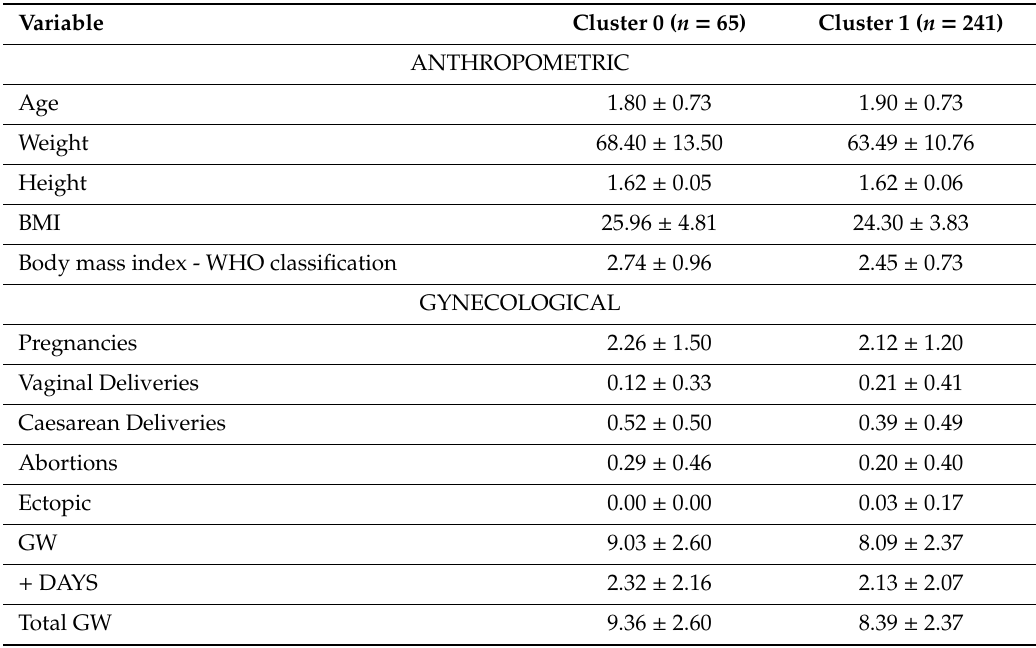
Table 4. Characteristics stratified by all the features without perinatal and pregnancy complication results. Features are presented as mean ±